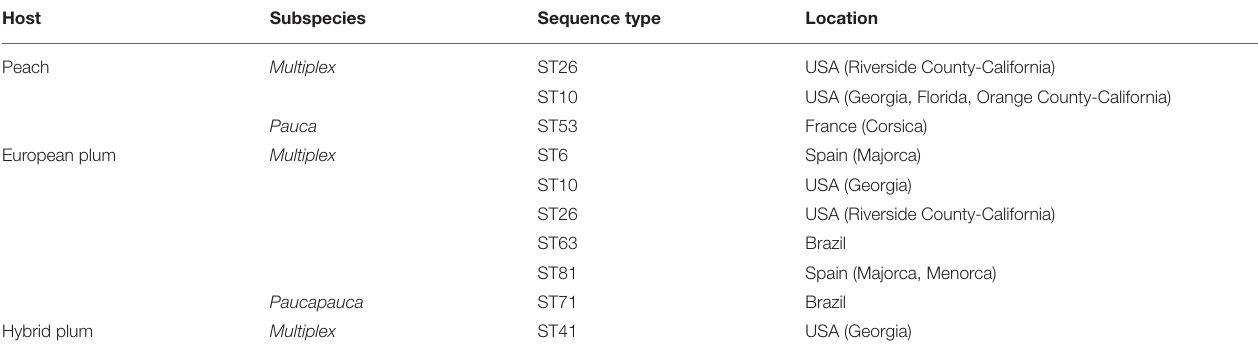
TABLE 2 | Sequence types found on peach ( P. persica ), European plum ( P. domestica ), and Japanese plum ( P. salicina ) trees and location (Della Coletta-Filho et al., 2017; EFSA, 2020; www.pubmlst.org).